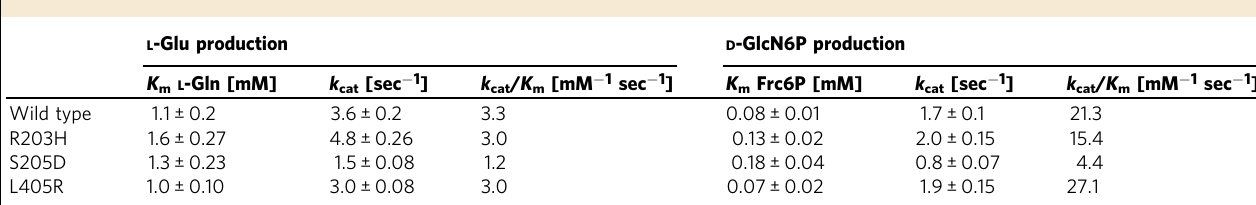
Table 1 Kinetic